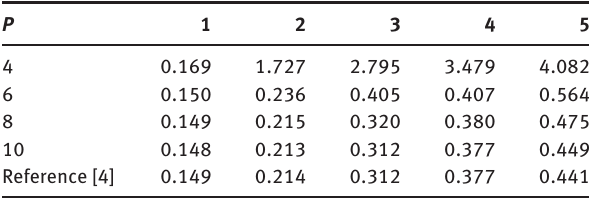
Table 2: Convergence and comparison of the first five frequency parameters Ω of the clamped laminated composite [30 ° , -30 ° , 30 ° ] circular plate.